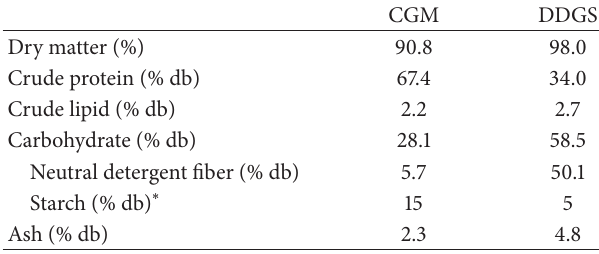
Table 1: Composition of the raw protein sources used in the study ∗